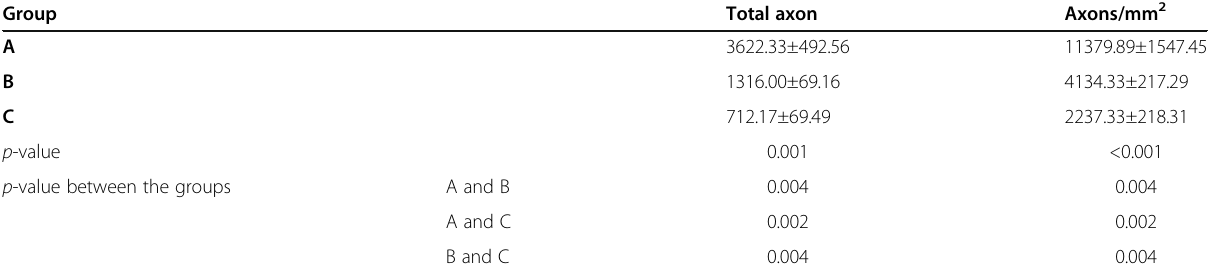
Table 1 Total number of axons, and axons/mm2 in groups A (sham), B (0.7 N tension stretch), and C (1.5 N tension stretch) Group